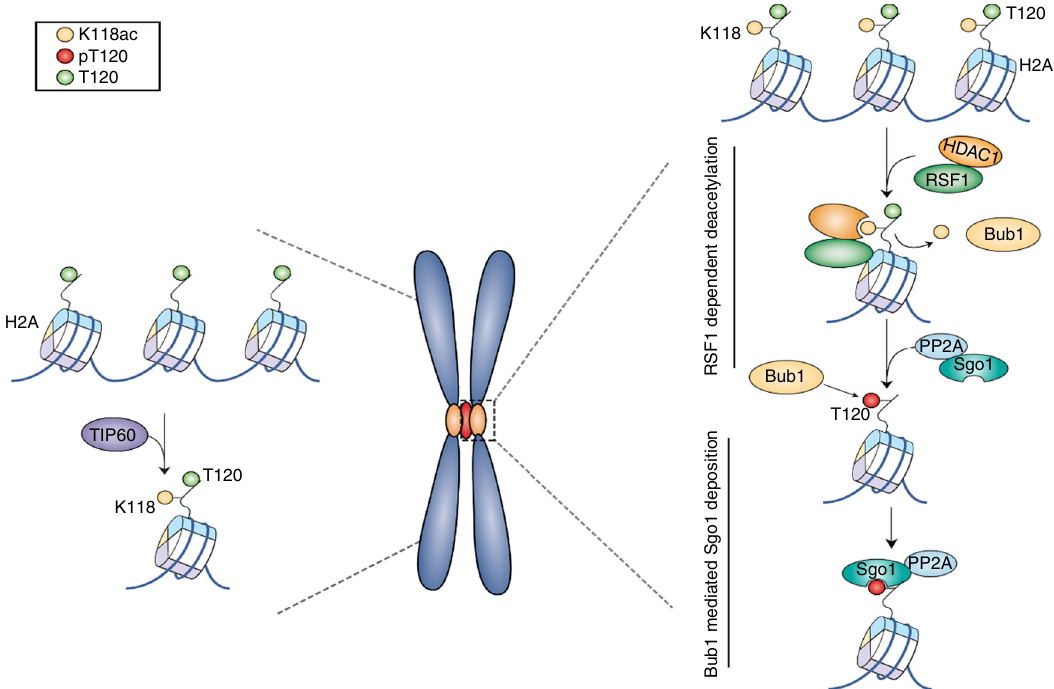
Fig. 7 A proposed model for sister chromatid cohesion by RSF1. In our model, Tip60 contributes to maintaining H2A-K118ac at chromosome arms and RSF1-bound HDAC1 at centromeres counteracts it, allowing the phosphorylation of H2A at T120 by Bub1. Green circle represents H2A-T120 and red circle is its phosphorylated form (H2A-pT120). Yellow circle represents acetylation of H2A at Lys 118